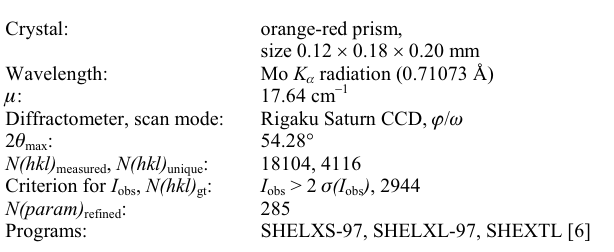
Table 1. Data collection and handling.